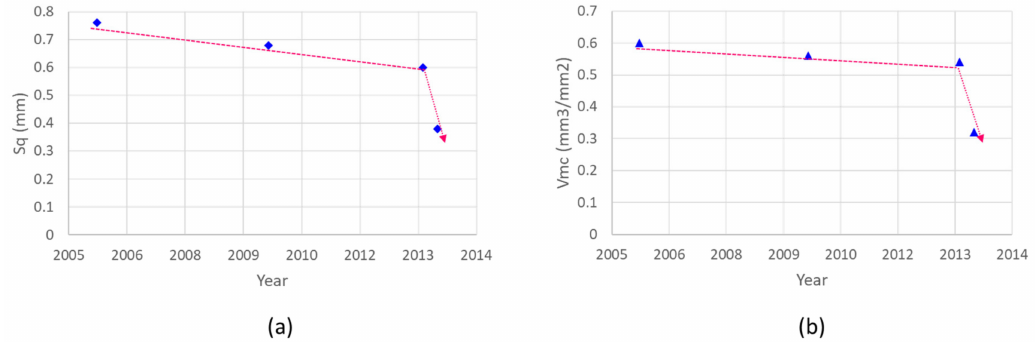
Figure 18. Plot of ( a ) Sq and ( b ) Vmc texture parameter values based on an artificial timeline corresponding to friction